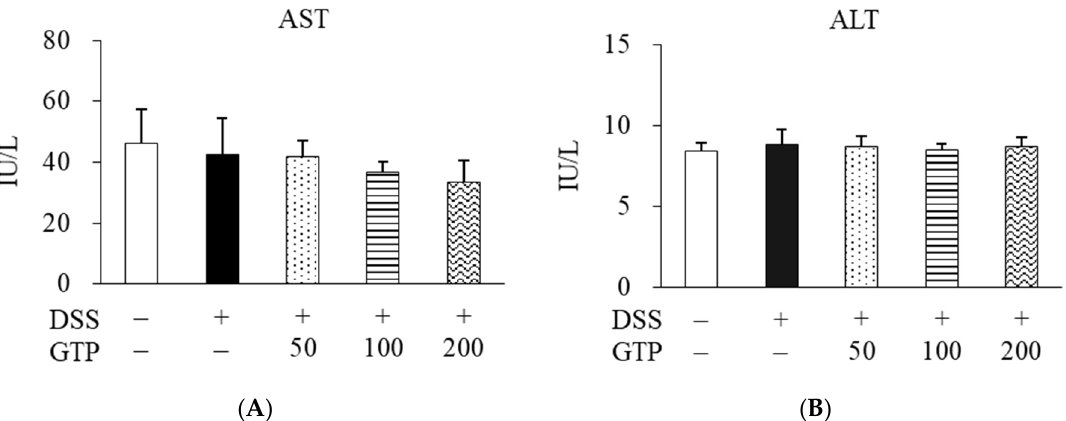
Figure 3. Effect of GTP on serum AST ( A ) and ALT ( B ) levels. Serum AST and ALT were measured by enzymatic colorimetric methods. Values are expressed as mean ± standard error ( n = 7). GTP, green tea complex containing Piper retrofractum fruit; AST, aspartate aminotransferase; ALT, alanine aminotransaminase; DSS, dextran sulfate sodium.